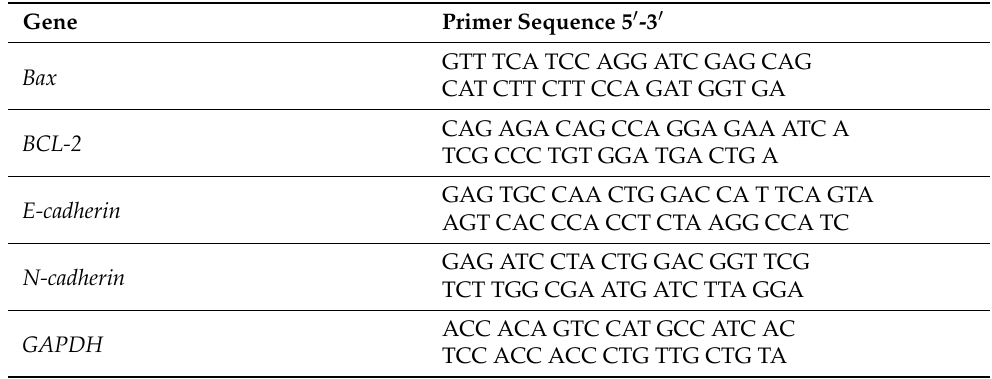
Table 4. Primer sequence for the genes used in RT-PCR.